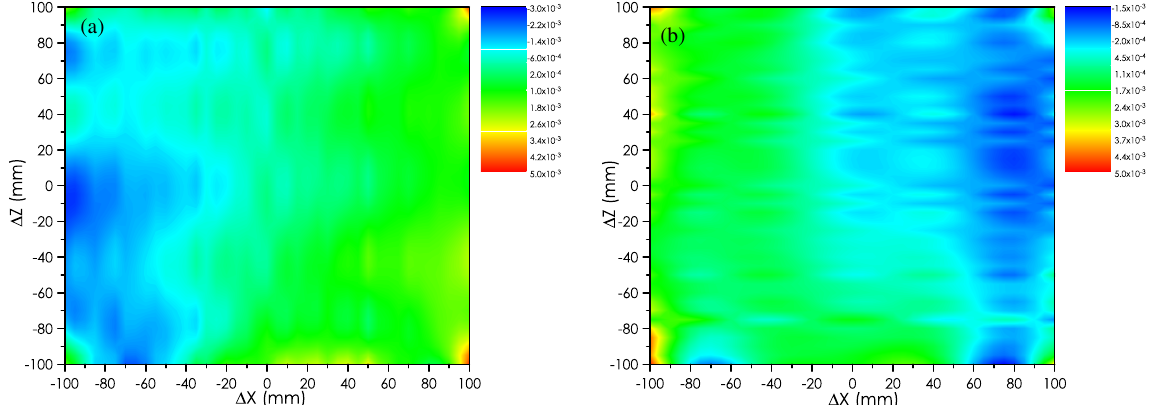
FIG. 16. Uniformity of the (a) horizontal GL, (cid:1) G x L=G x L , and (b) vertical GL, (cid:1) G z L=G z L , products along beam trajectory for the large-aperture magnet after